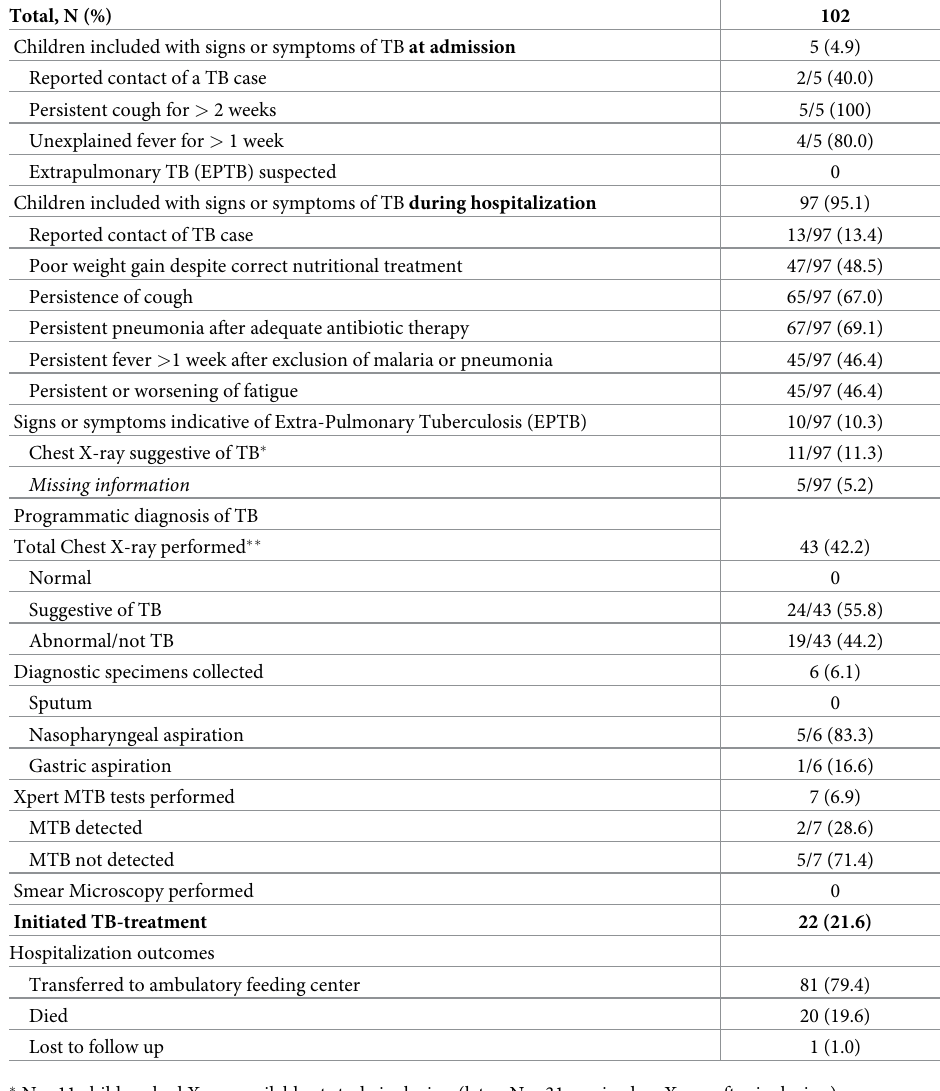
Table 2. Signs and symptoms of TB at inclusion and TB diagnosis in Group